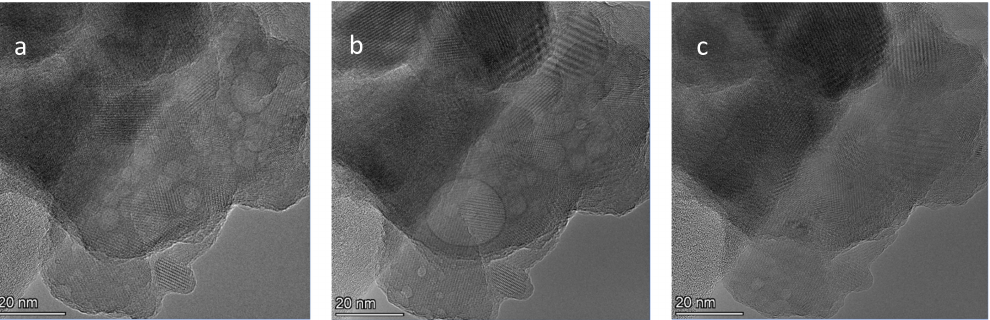
Figure 7. Changes in the HRTEM image of a particle containing bubbles after 1 s ( a ), 30 s ( b ), and 60 s ( c ) of electron beam exposure. Ca/P = 1.42. A video showing these changes is presented as Supplementary Material.